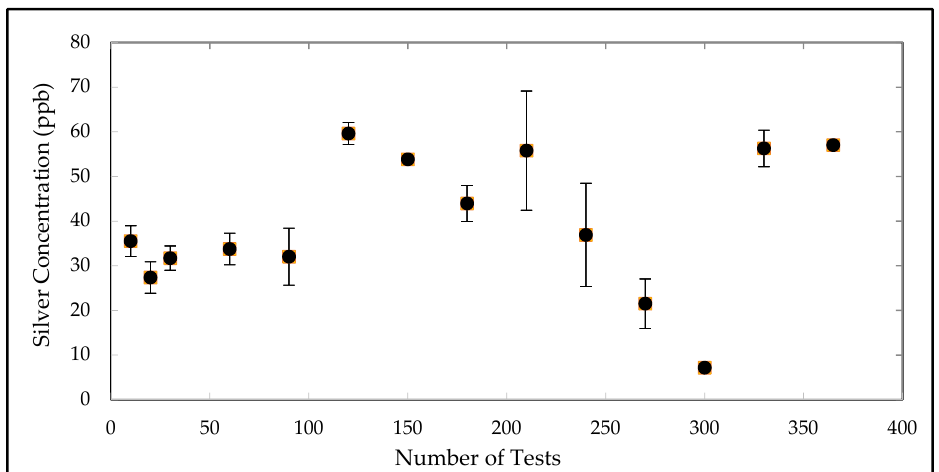
Figure 10. Silver release in 10 L synthetic groundwater as a function of the number of tests on the